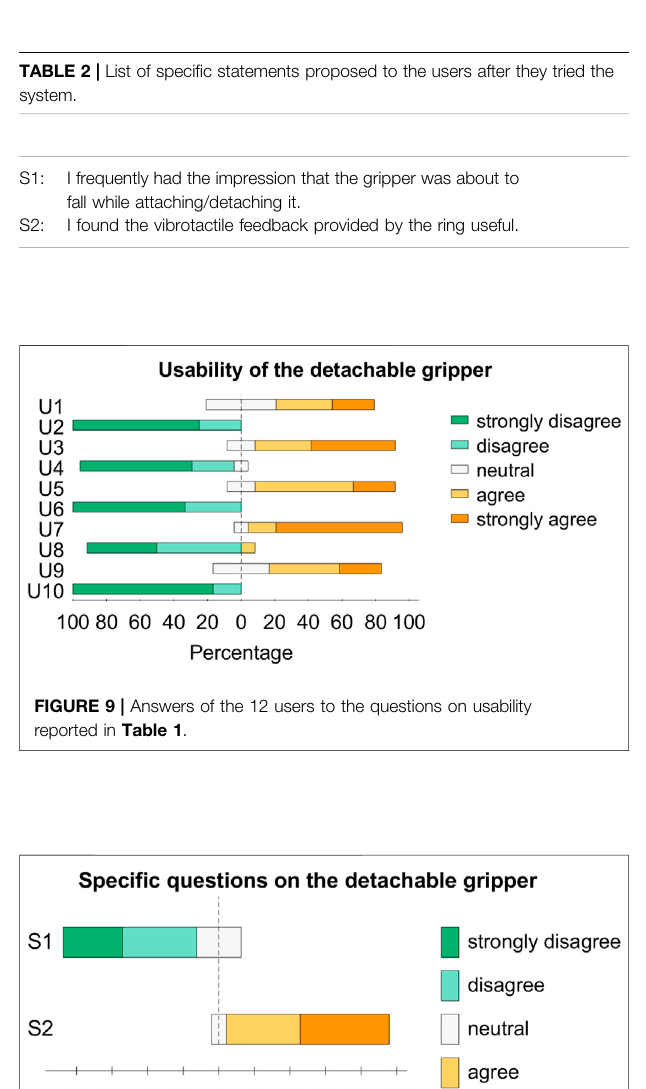
Frontiers in Robotics and AI |